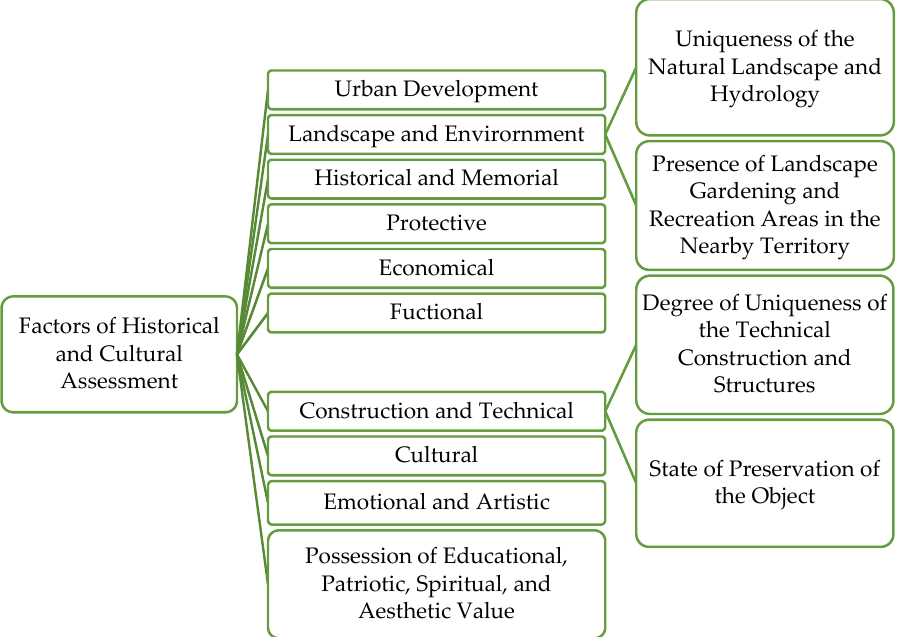
Figure 6. Factors of historical and cultural assessment of territories.